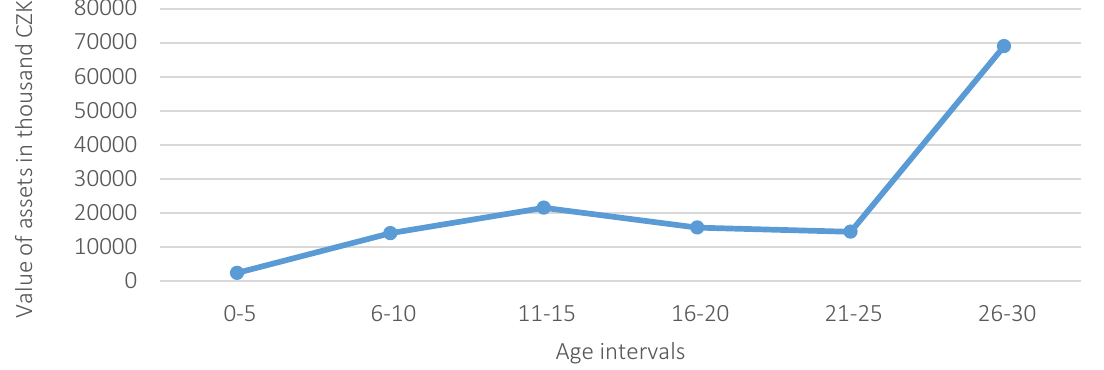
Figure 3. Value of total enterprise assets (measured in thousand